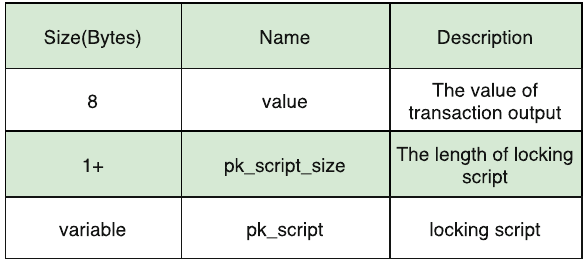
Fig. 3 Structure of transaction output